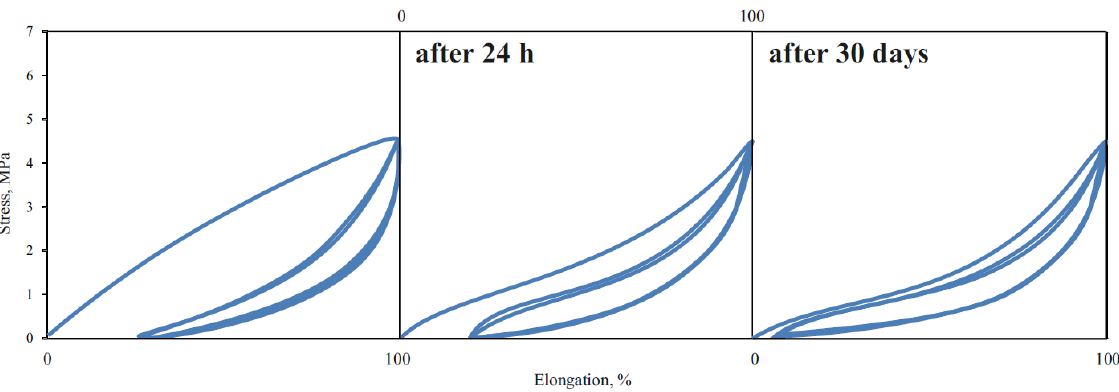
Figure 18. Mechanical hysteresis loops of the 3GT-DLAol-PA12 (polymer 12).